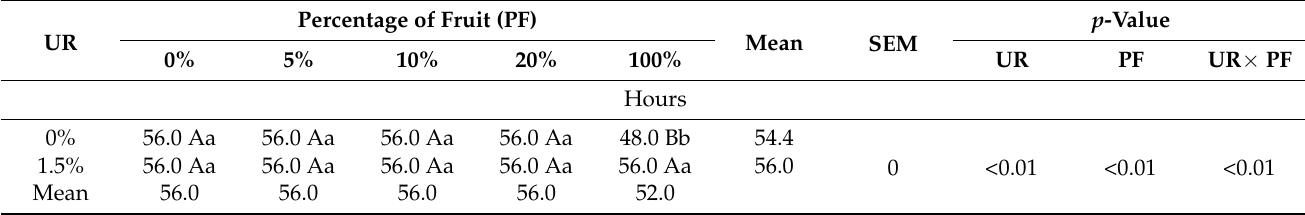
Table 7. Aerobic stability of silages with different mixtures of melon biomass and addition of urea, after silo